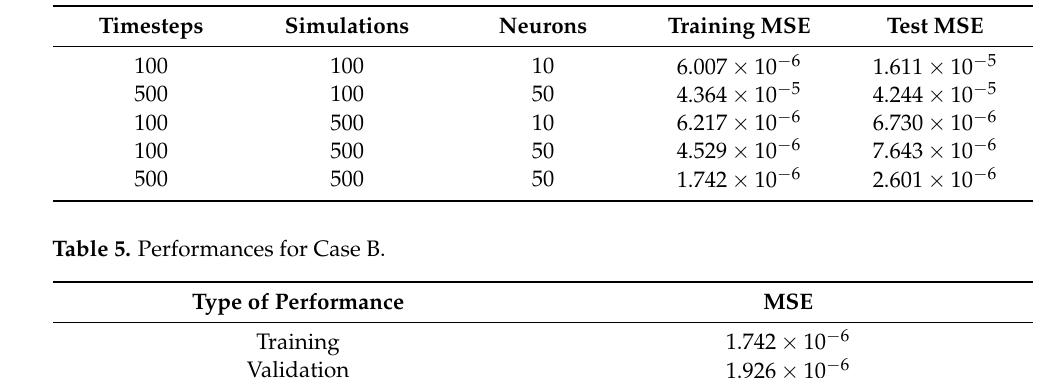
Table 4. Settings tried for Case B and relative performances.